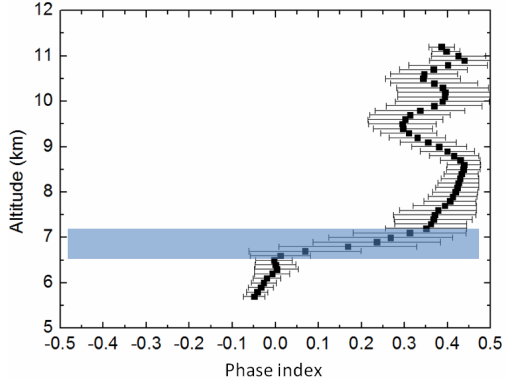
Figure 8. Mean phase index profile for cloud scene shown in Fig. 6. The mixed-phase layer is indicated by the colored